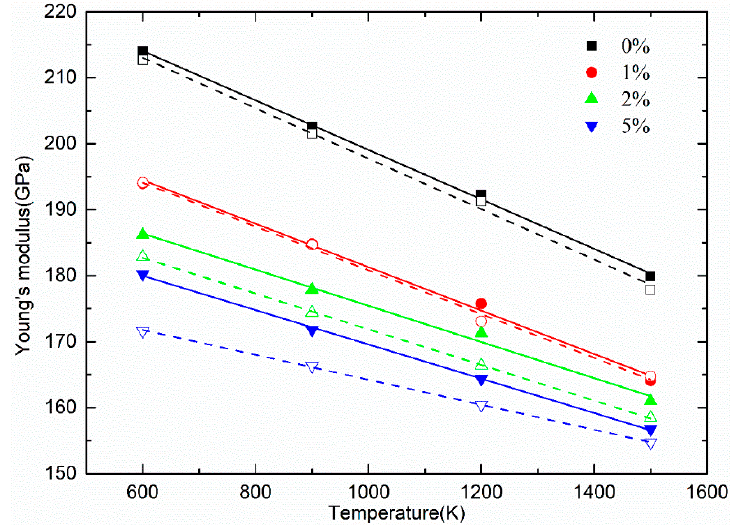
Figure 7. Variation of Young’s modulus of UO 2 containing different concentrations of Frenkel (dash) and antisite (solid) defects versus temperature. The fitted lines are also included in the figure.